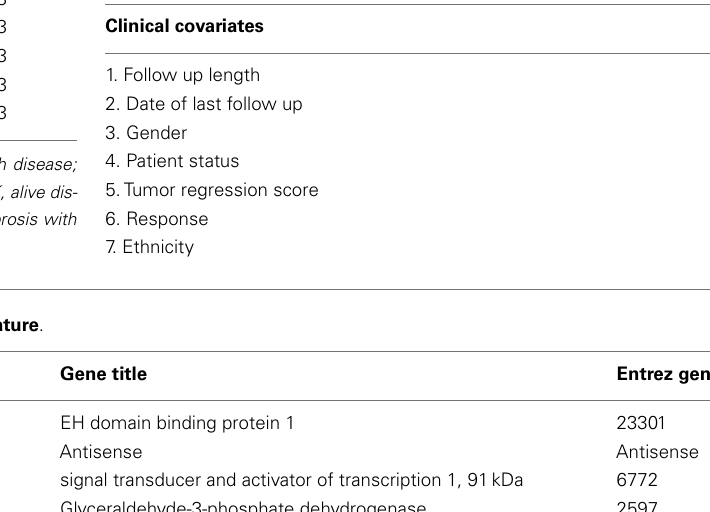
Table 3 | List of clinical covariates used in testing for independence of genetic signature prediction .